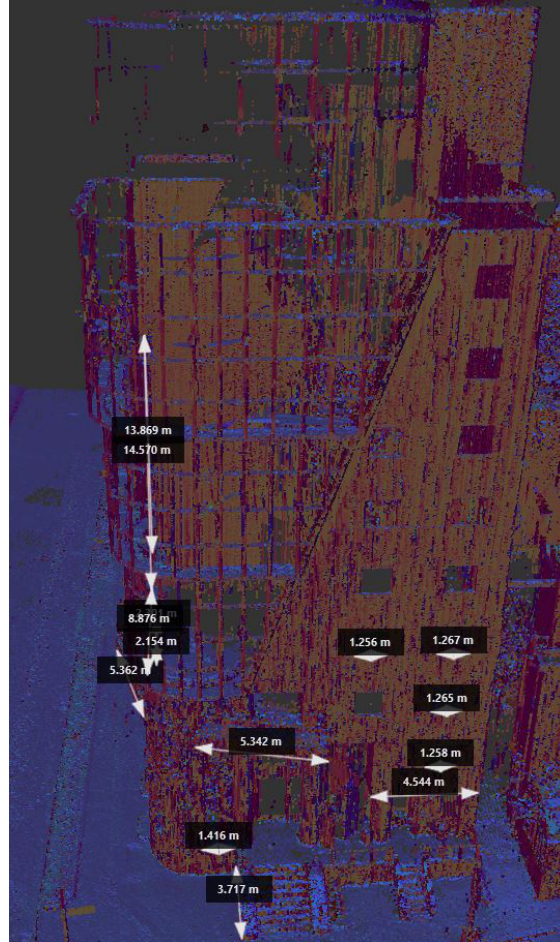
Figure 23: Control